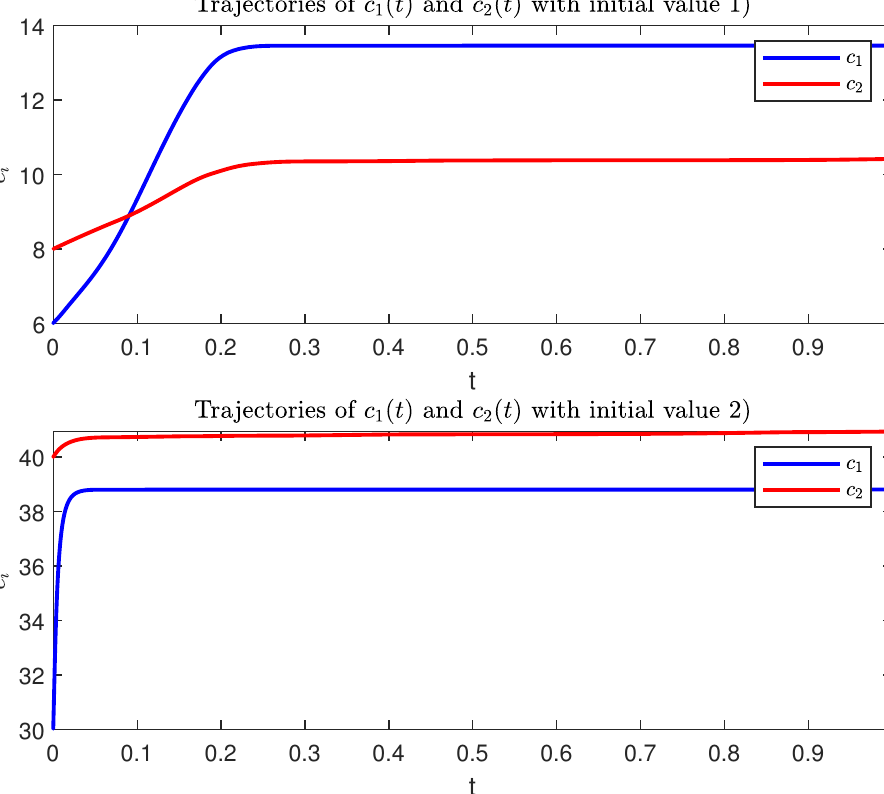
Figure 6. The trajectories of c 1 ( t ) and c 2 ( t ) under initial values (1) and